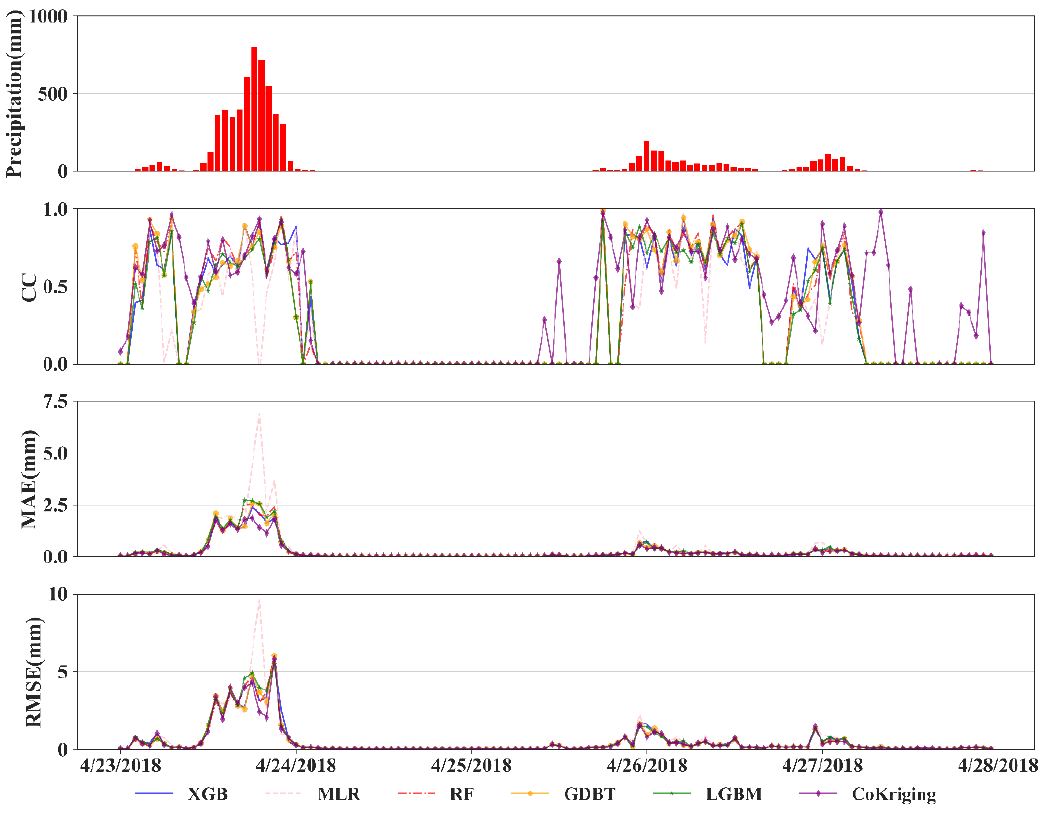
Figure 8. Evaluation indices of heavy rainfall event I.